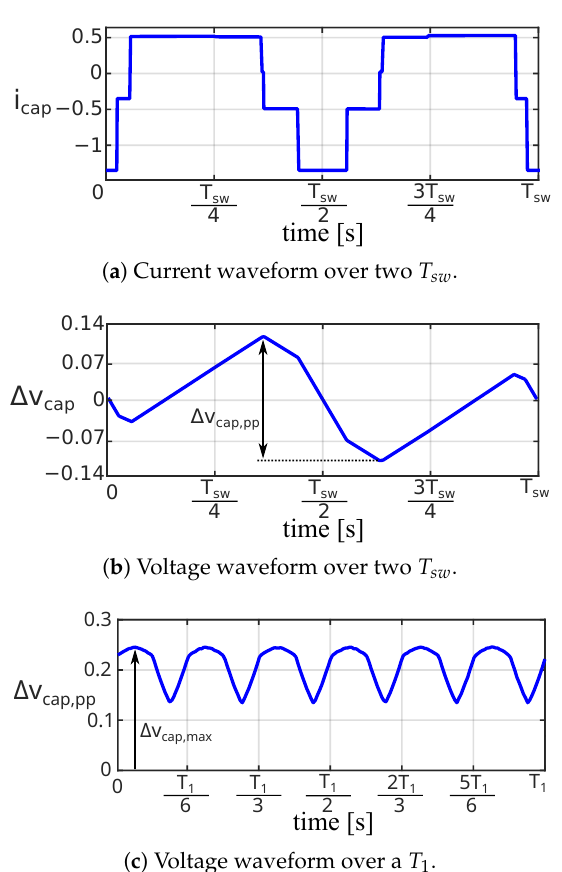
Figure 5. Normalized current and voltage in the DC-Link capacitor with SPWM technique, M = 0.9 and cos φ =